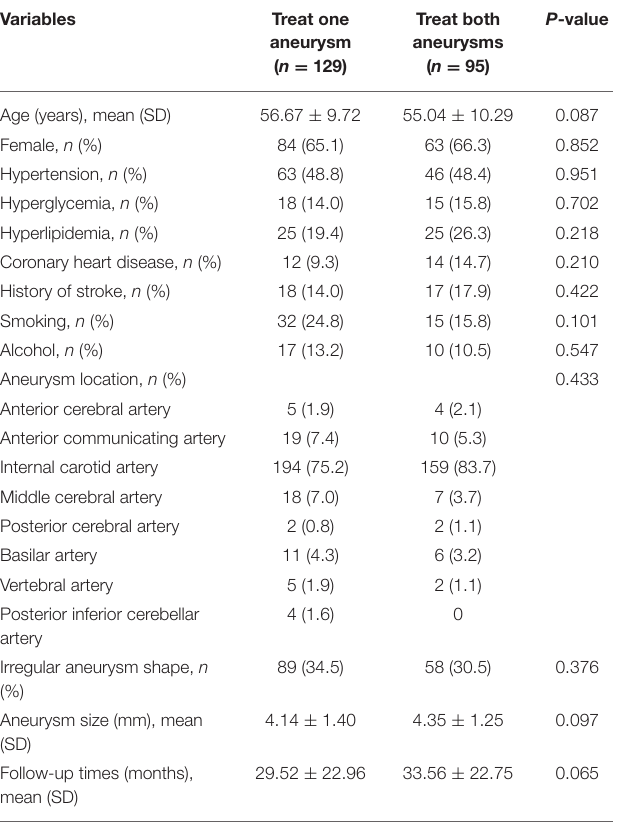
TABLE 2 | Comparison among patients who had one aneurysm treated and both aneurysms treated.